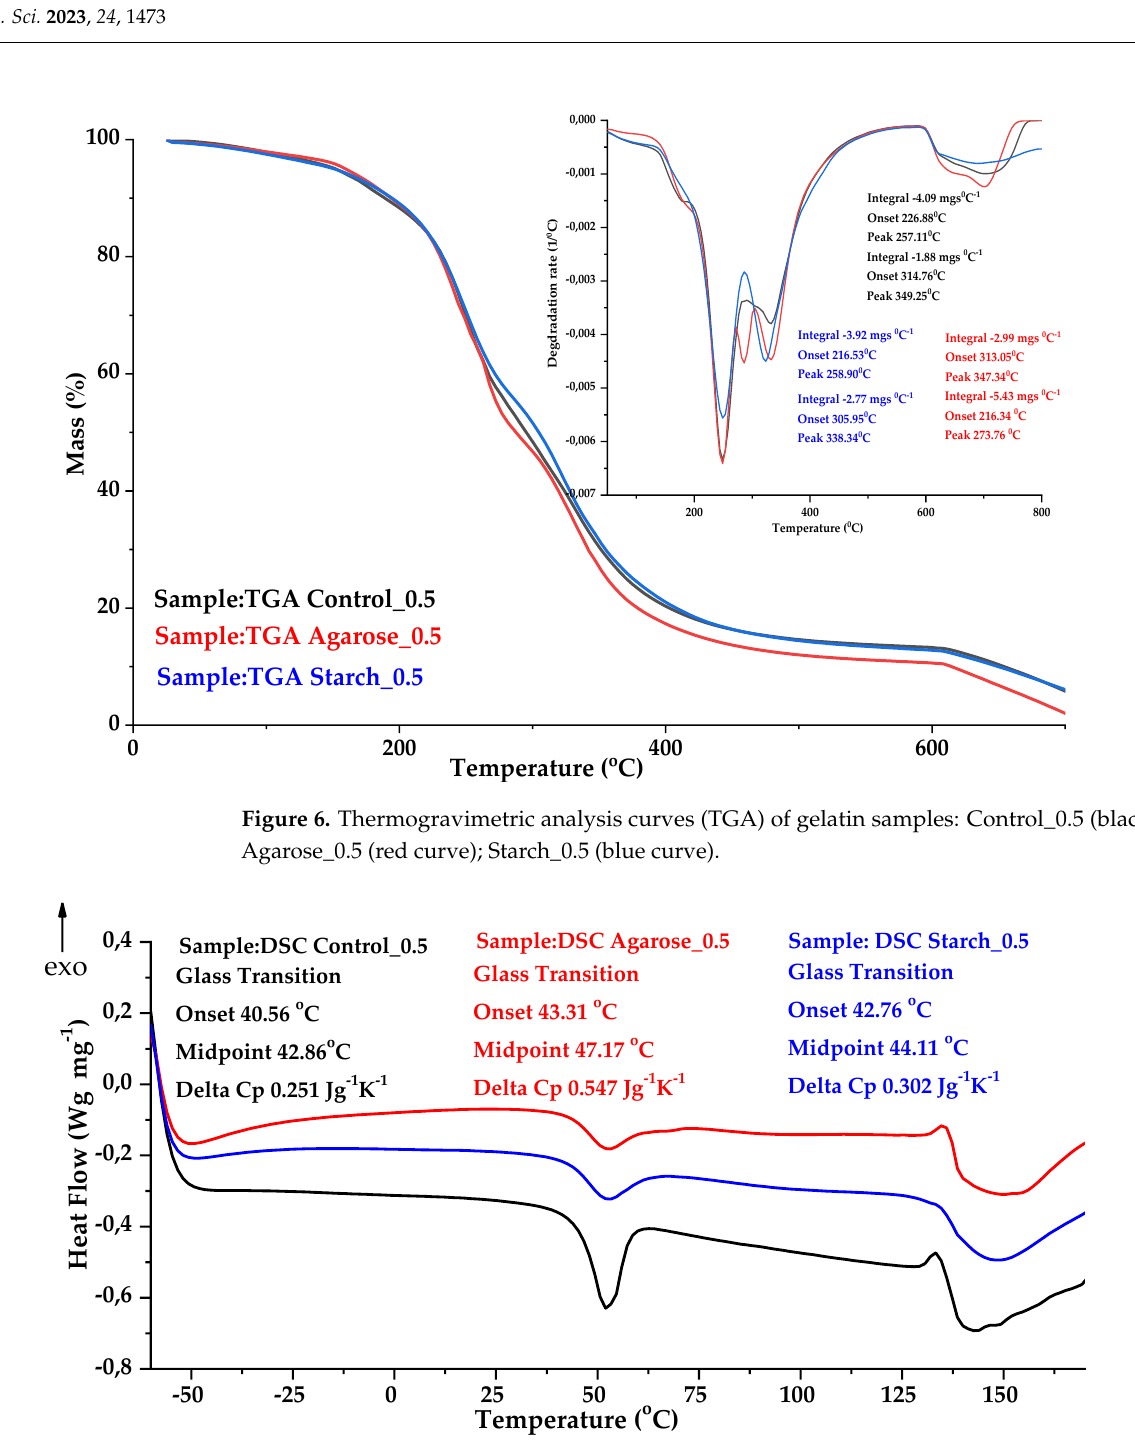
Figure 7. Comparison of DSC analysis curves for gelatin samples: Control_0.5 (black curve); Agarose_0.5 (red curve); Starch_0.5 (blue curve).